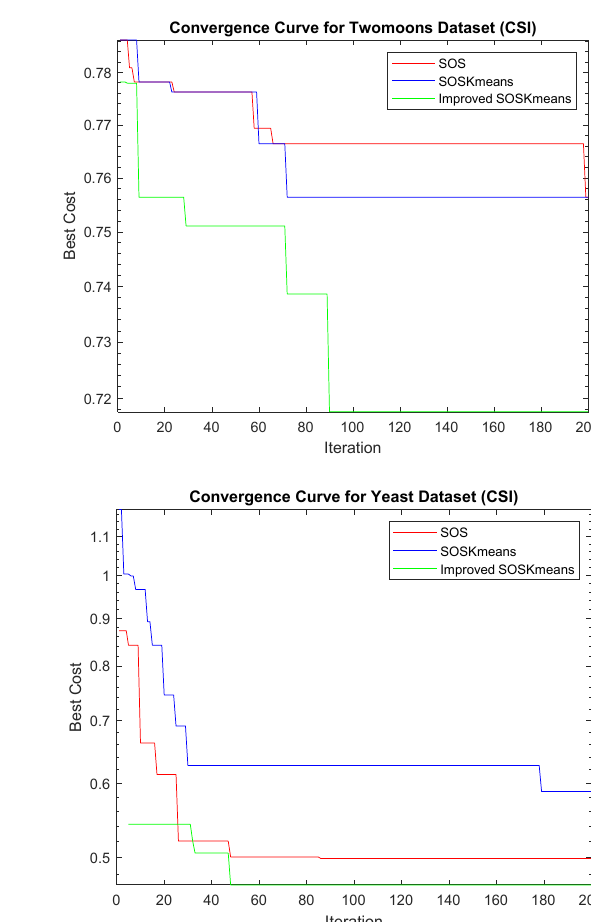
Table 6. Computational results of ISOSK-means on 18 synthetic datasets.